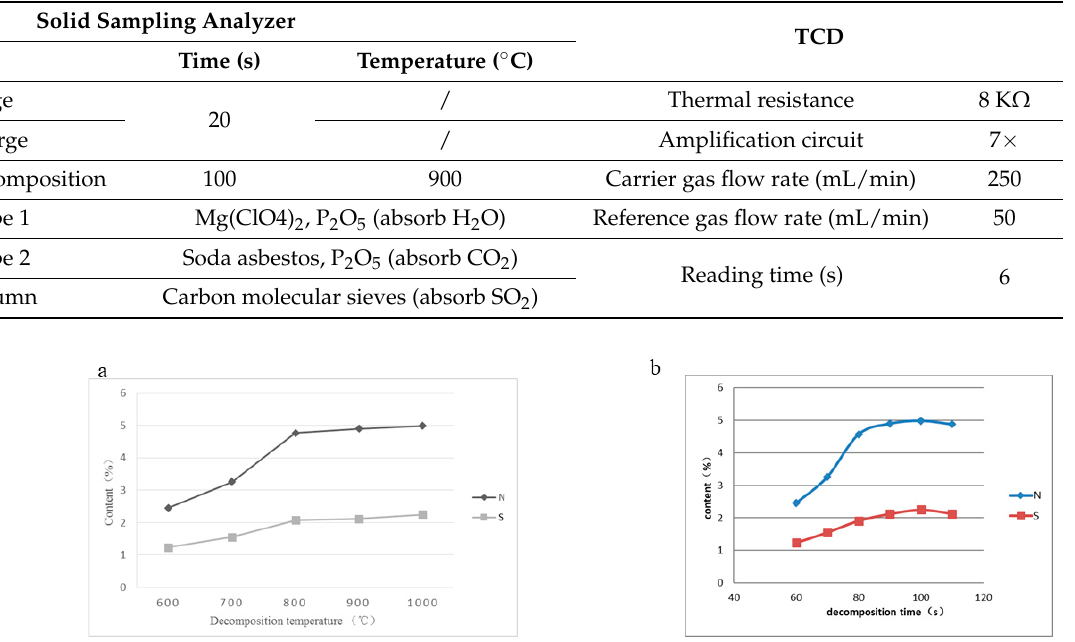
Table 1. Instrumental program of solid sampling system.